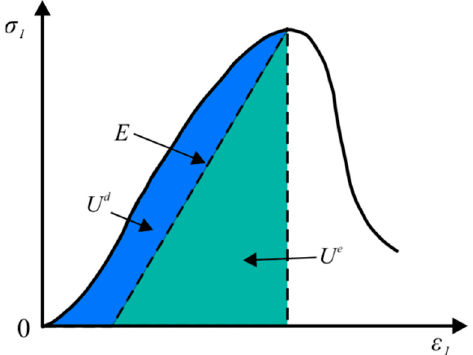
Figure 4. The elastic strain energy and dissipated energy in the rock.